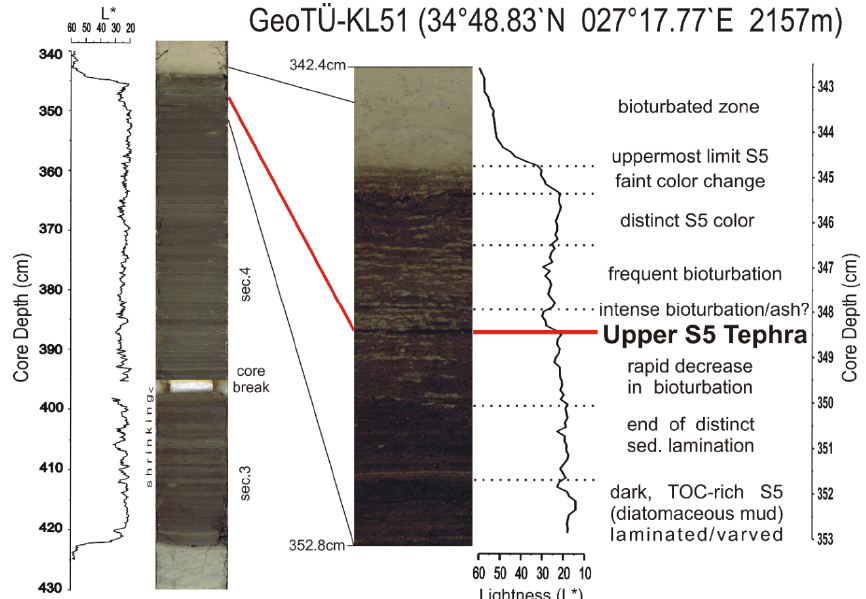
Figure 3. Detailed core photograph and sedimentological features of core KL51 showing the position and preservation of the KL51 S5 tephra layer and the correction for shrinkage in the core between Sections 3 and 4. The KL51 S5 tephra layer is located at an original depth in the core of 346.3–346.8 cm (see [60]) which after correction for core shrinkage, becomes 348.3–348.8 cm. This study uses the original depth of 346.3–346.8 cm to retain consistency with previous studies